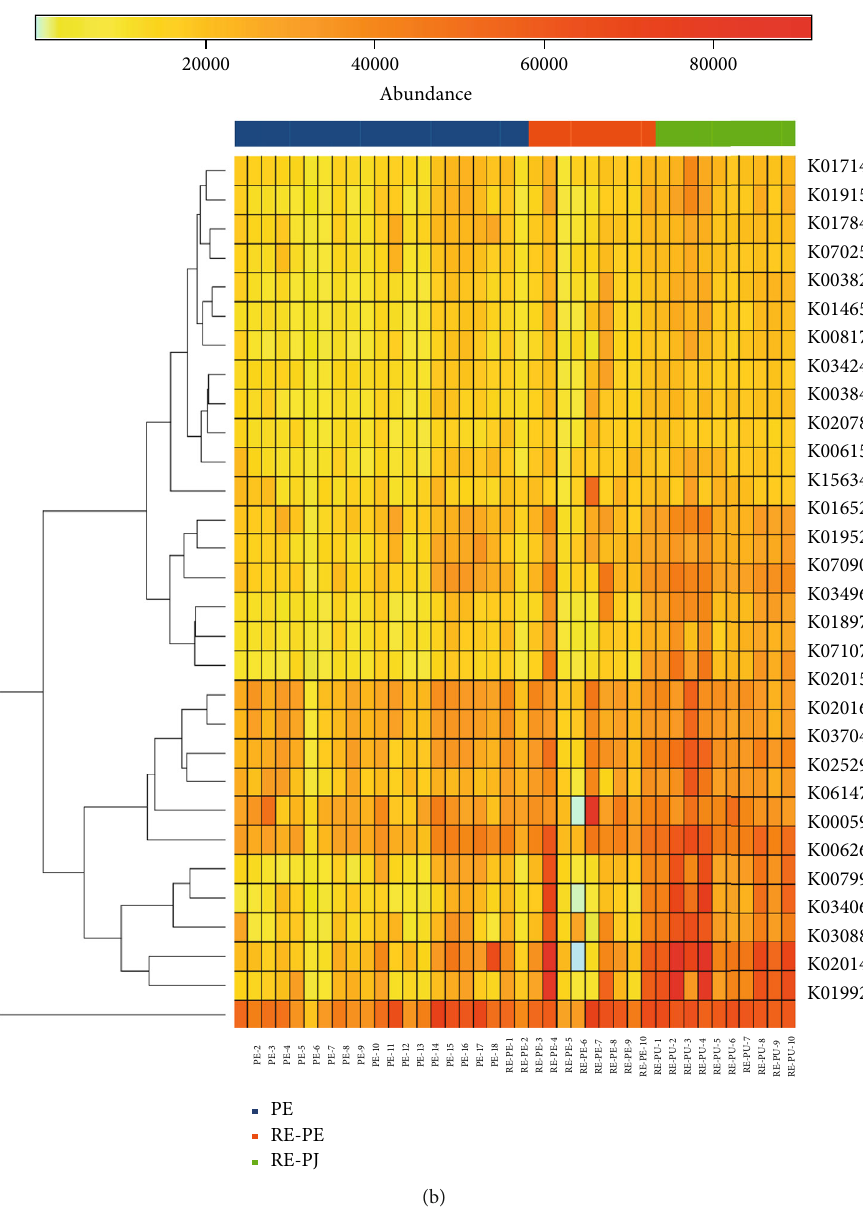
Figure 5: The heat map of Kyoto Encyclopedia of Genes and Genomes (KEGG) pathway categories based on di ff erently detected genera of (a) PE, RE-PE, and RE-PU and (b) PU, RE-PE, and